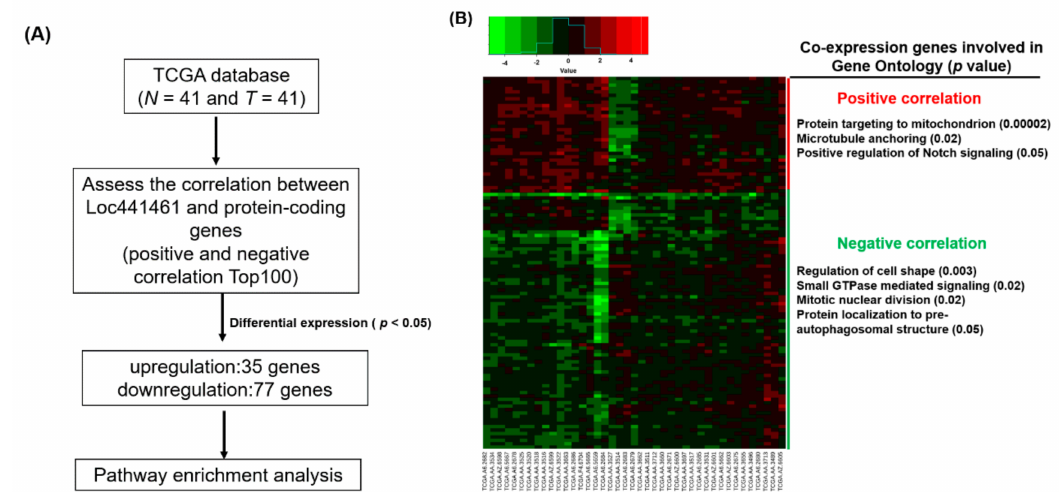
Figure 2. Identification of LOC441461-coexpressed genes through the TCGA database and